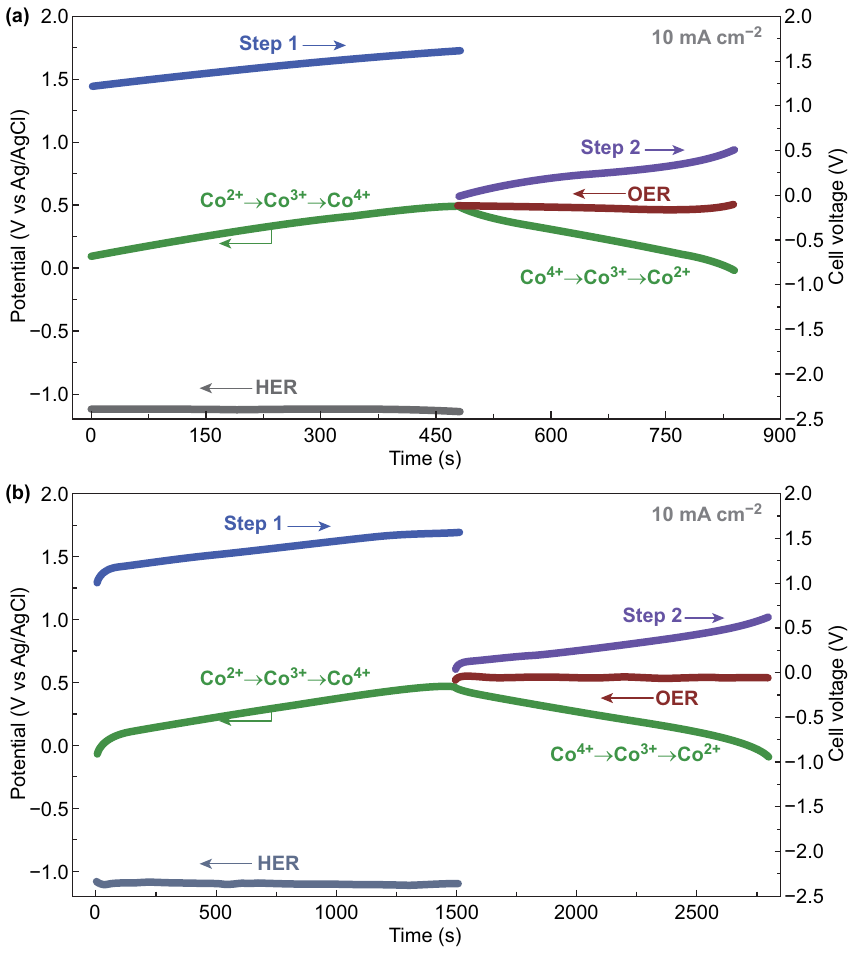
Fig. 4 Chronopotentiometry data (potential vs. time) of batch reactor using a pure CoP or b Co 2 P/CoP NAs electrode. Chronopotentiometry curves were recorded at a current density of 10 mA cm −2 . [(Voltage of Step 1) = (potential of Co charge)—(potential of HER); (voltage of Step 2) = (potential of OER)—(Potential of Co discharge)]. Voltages for H 2 production (Step 1) and O 2 production (Step 2) are labeled using the blue and purple lines, respectively. Chronopotentiometry data (potential vs time) of HER electrode, mediator electrode and OER electrode are labeled using the gray, green and crimson lines, respectively. (Color figure